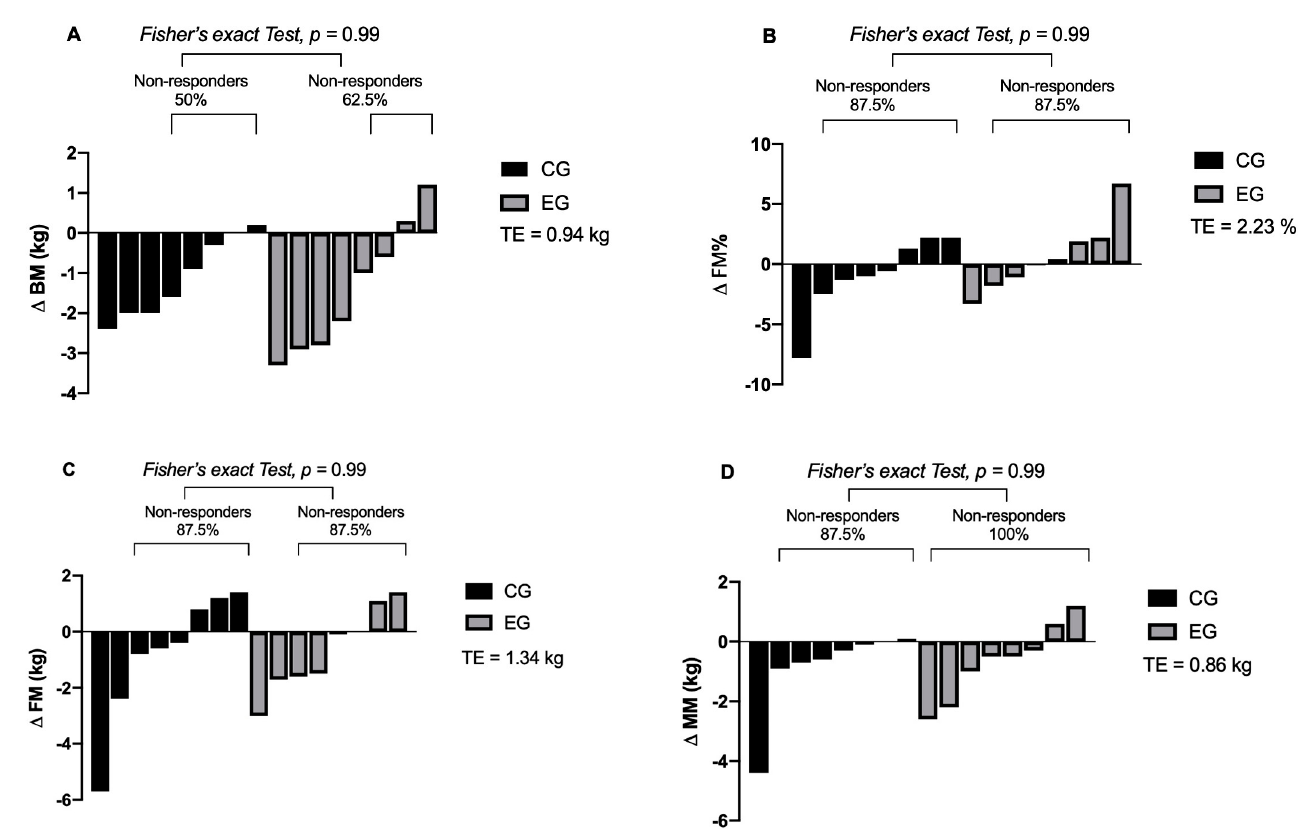
Figure 4. Inter-individual variability of the response of HIIT intervention and traditional training on body composition in taekwondo athletes. Means: p : p-value; TE: technical error; percentage change expressed as percentage delta. Symbolises: A : BM: body mass, B : FM%: fat mass percentage, C : FM: fat mass; D : MM: muscle mass.